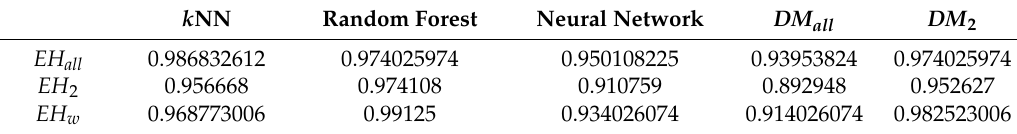
Table 8. The RScore of each enhanced risk detection model for its new training data. k